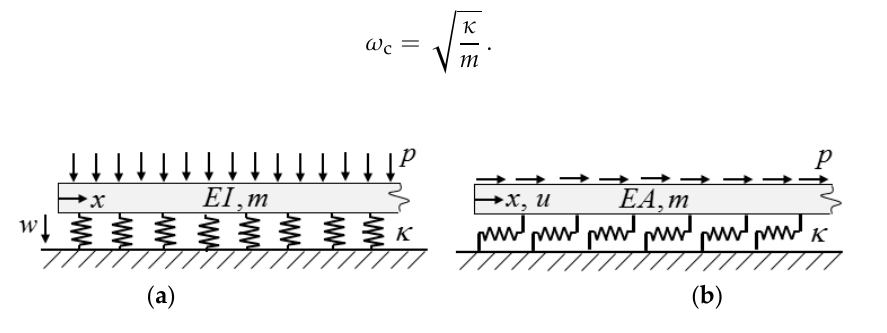
Figure 4. Beam on an elastic foundation ( a ) and a bar where the axial displacement is hindered by an elastic support ( b ).